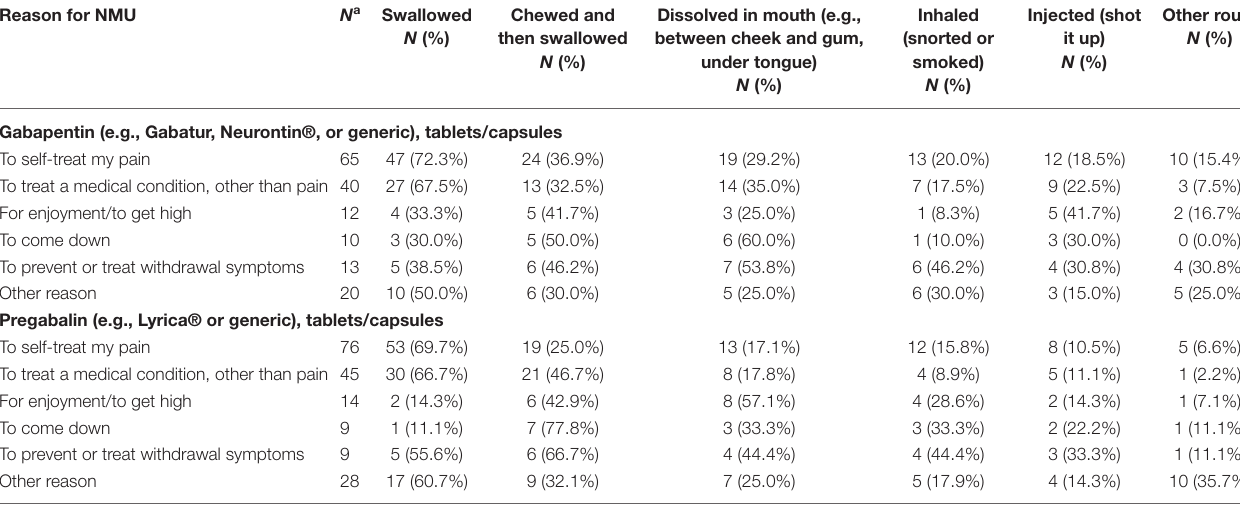
TABLE 6 | Route of administration by reason for non-medical use in Spain. Reason for NMU